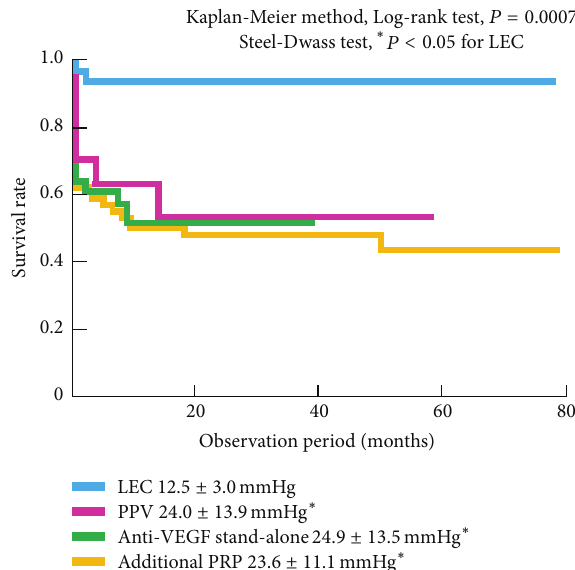
Figure4:IOPprogressionaccordingtobyNVGtreatment.LEChad the strongest continuous hypotensive effect, resulting in persistent declinesinIOP( ≤ 21 mmHg)inmorethan90%ofpatients.IOPoften increased several months after treatment, except following LEC.